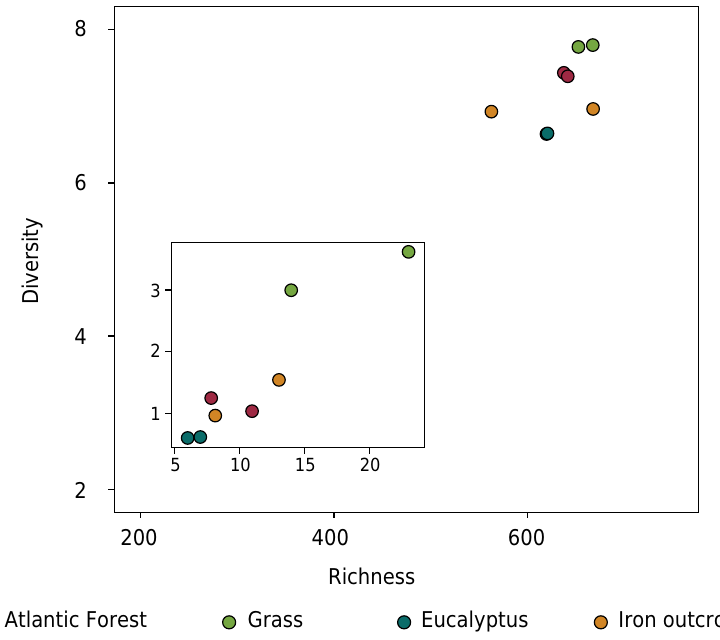
Atlantic Forest Iron Figure 2. The α-diversity – observed ASVs for richness and Shannon diversity – of total fungi (bigger graph) and only yeast (inside graph).